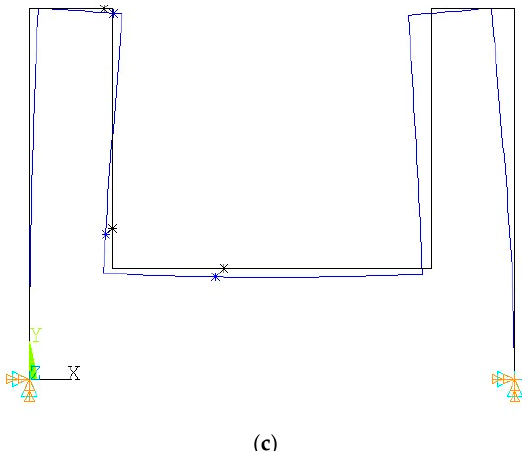
Figure 5. Submerged pipeline model and its finite element model: ( a ) polyvinyl chloride (PVC) pipeline in the seawater container; ( b ) finite element (FE) model; ( c ) first vibration mode shape.